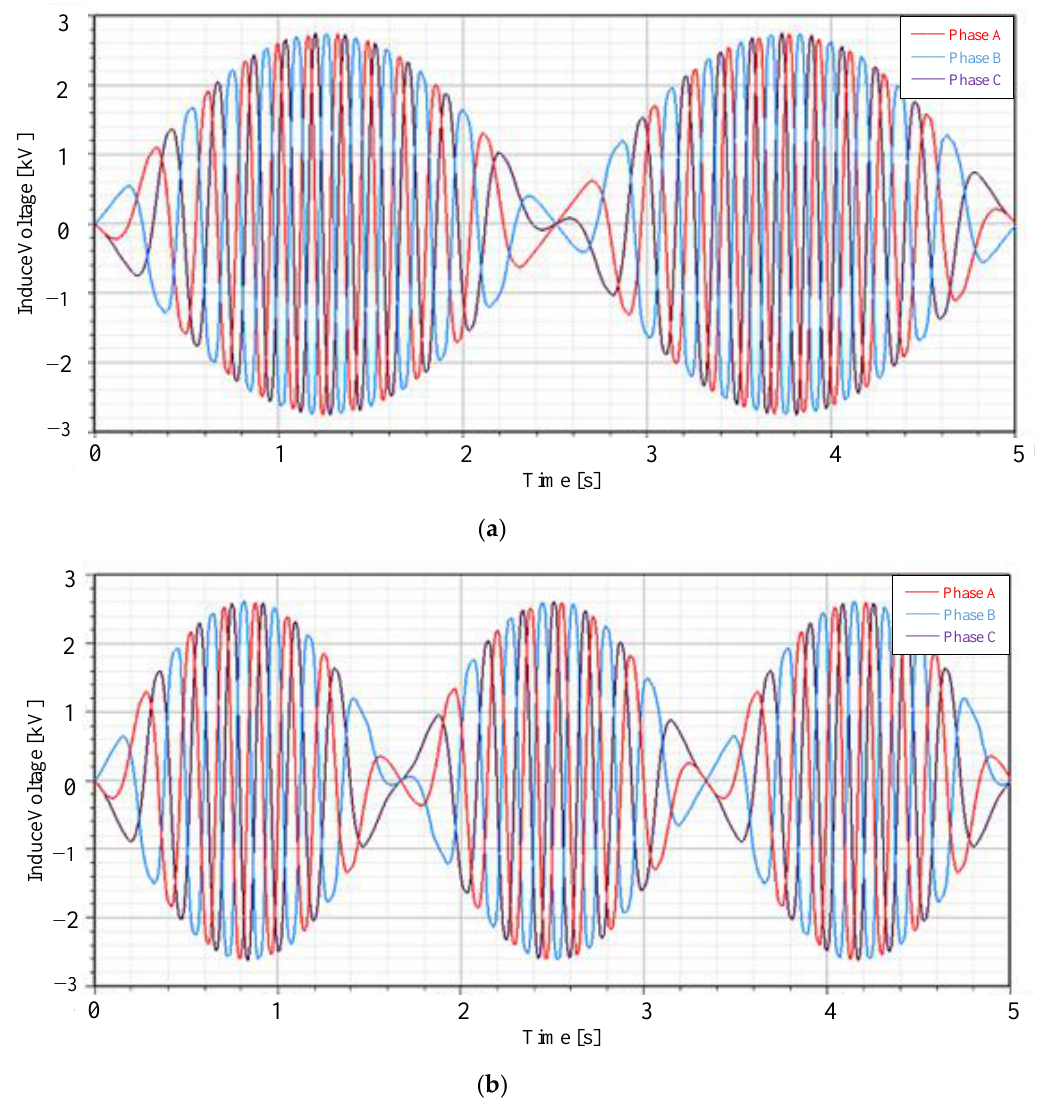
Figure 12. Induced voltages of CPMLG directly driven by WEC. ( a ) 0.2Hz; ( b ) 0.3Hz.